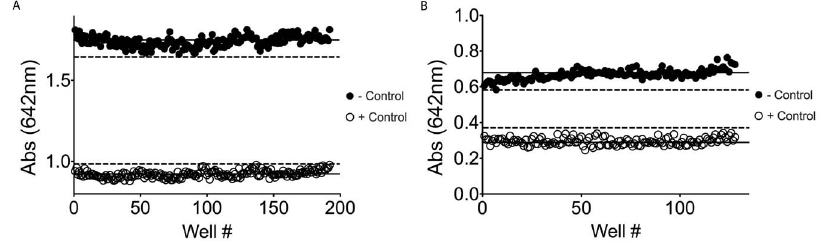
Figure 4. Determination of the Z-factor for 384-well and 1536-well assay. (A) In a 384-well plate, 192 wells were used as a negative control (buffer only), represented by closed circles. An additional 192 wells were used as positive controls and were treated with CCG-50014, a potent RGS4 inhibitor, (10 m M final) represented by open circles [29]. The solid lines represent the mean value for the negative control and the positive control (1.74 and 0.92 respectively). The dashed lines marks the 3 standard deviation cut off for both the positive and negative control (standard deviation of 0.033 and 0.021 respectively). (B) This assay was conducted in 5.5% DMSO to mimic the actual concentration of DMSO in the pilot screen. In a 1536- well plate, 128 wells received buffer, negative control (closed symbols) and the remaining 128 wells received 10 m M final CCG-50014, positive control (open symbols). The solid lines represent the mean value for the negative control and the positive control (0.67 and 0.30 respectively). The dashed lines marks the 3 standard deviation cut off for both the positive and negative control (standard deviation of 0.028 and 0.021